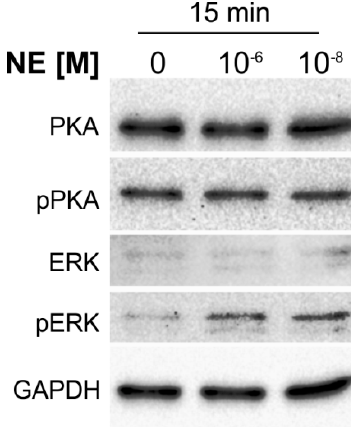
Figure 3. NE-mediated activation of intracellular signaling pathways in chondrocytes. No changes in PKA phosphorylation are visible, while both low and high NE concentrations increase phosphorylation of ERK after 15 min (representative images of cells isolated form one OA